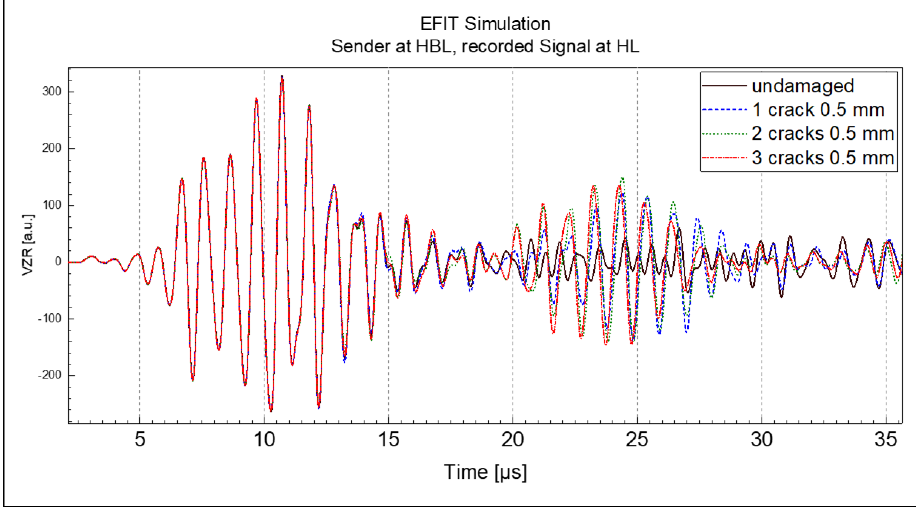
Figure 10. EFIT simulation surface normal velocity signal recorded at HL, crack depth 0.5 mm.